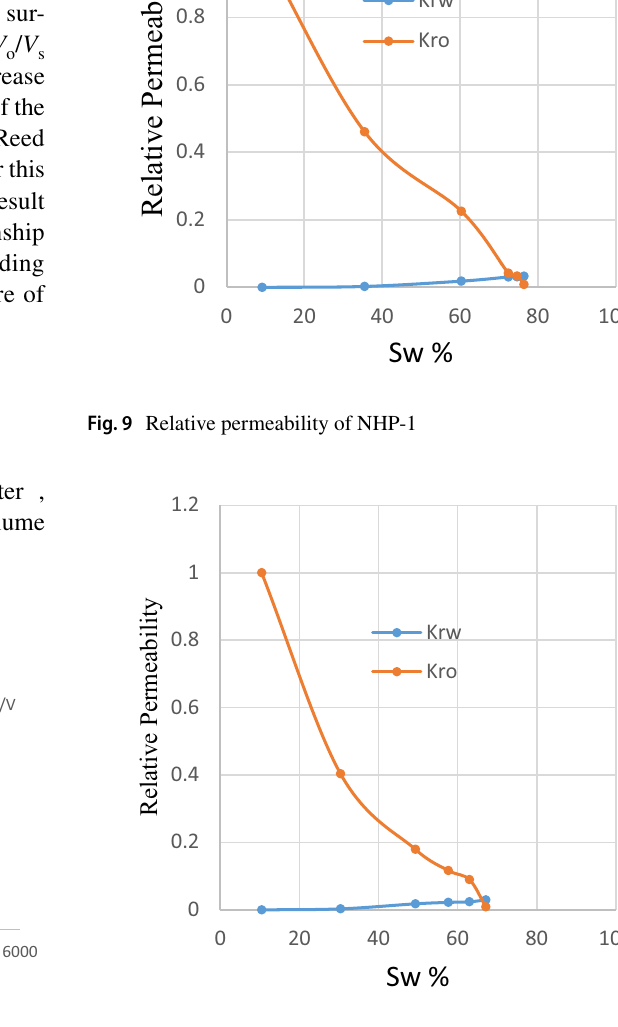
Fig. 10 Relative permeability of